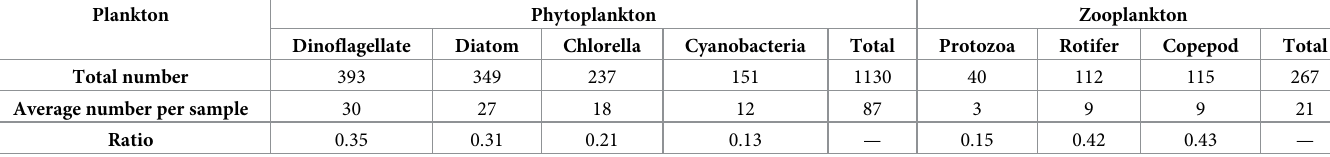
Table 6. Species and quantity of plankton in thirteen surface water samples from the salt marsh area.